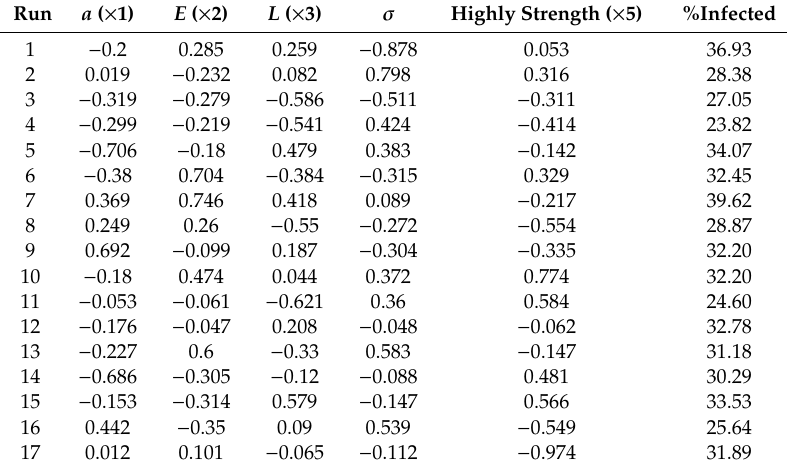
Table 2. Inputs and outputs of the Expected Integrated Mean Squared Error (EIMSE) experimental